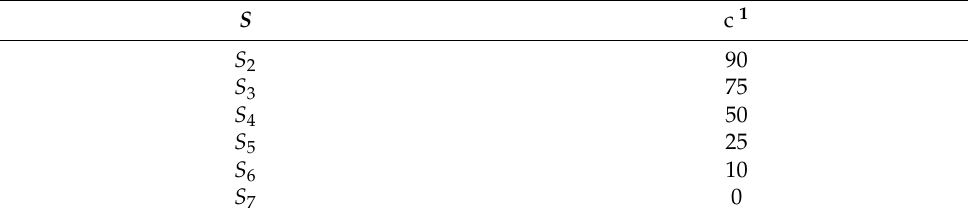
Table 2. List of S parameters for subsequent simulation research. S c 1 S